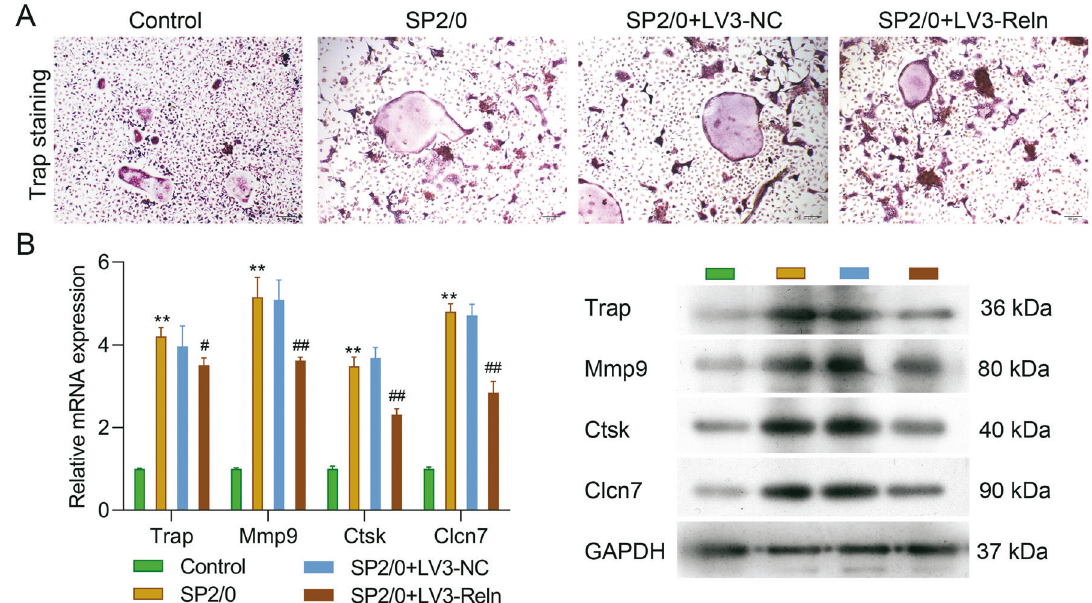
Fig. 5 Reduced Reelin expression inhibited osteoclast differentiation and osteolysis. We investigated whether Reelin down-regulation can attenuate the generalized osteoclast activation in isolated osteoclasts ( n = 6 per group). A Representative Trap staining images showing osteoclast activity for control, SP2/0, LV3-NC, and LV3-Reln groups. B mRNA and protein expression of osteoclastogenic genes examined by RT-PCR and western blotting respectively. Reln stands for Reelin. ** p < 0.01 vs. Control group; # p < 0.05, ## p < 0.01 vs. SP2/0